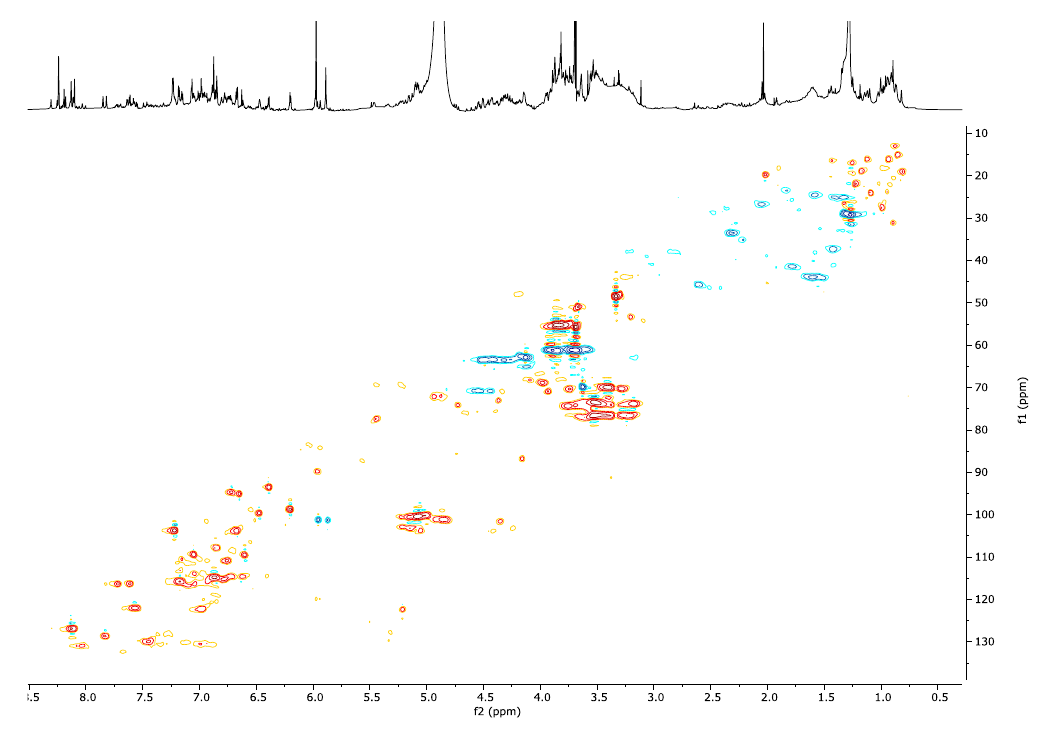
Figure 4. HSQC and 1 H-NMR spectra of the OdM fraction.